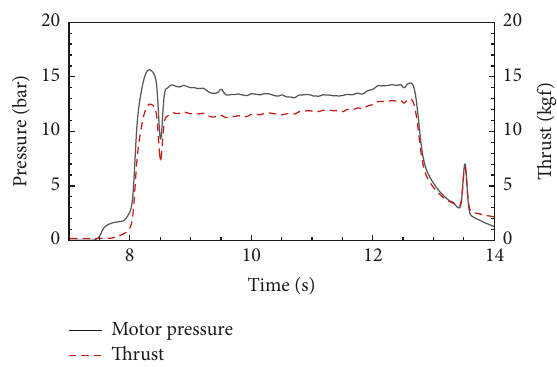
Figure 9: Pressure and thrust profile of test